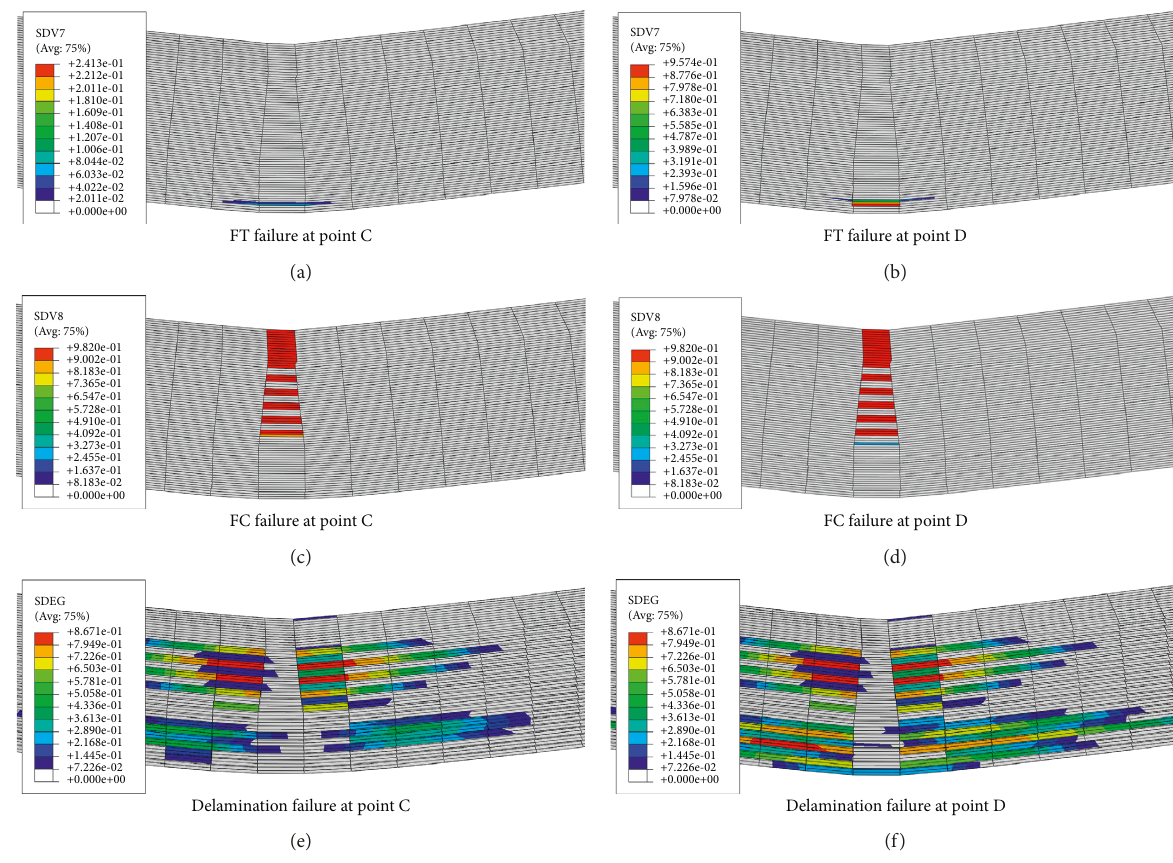
Figure 7: Failure modes at characteristic points C and D. (a) FTfailure at point C, (b) FTfailure at point D, (c) FC failure at point C, (d) FC failure at point D, (e) delamination failure at point C, and (f) delamination failure at point D.